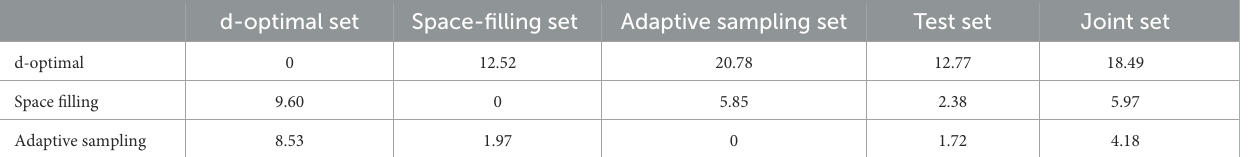
TABLE 4 Chest deflection mae of the trained models on the available datasets [mm].